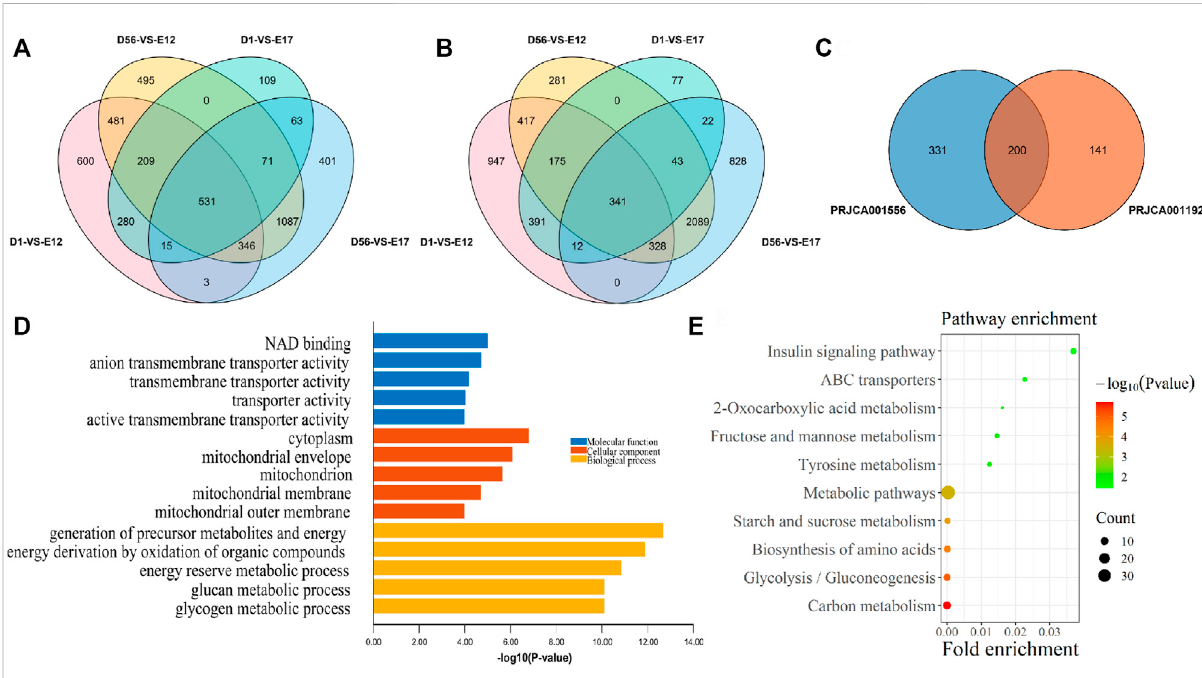
FIGURE 2 Functional enrichment analysis of postnatal-speci fi c highly expressed genes. (A) Venn diagram of DEGs from the PRJCA001556 dataset; (B) Venn diagram of DEGs from the PRJCA001192 dataset; (C) overlapping DEGs between PRJCA001556 and PRJCA001192 datasets; (D) GO enrichment analysis results of postnatal-speci fi c highly expressed genes; and (E) KEGG enrichment analysis results of postnatal-speci fi c highly expressed